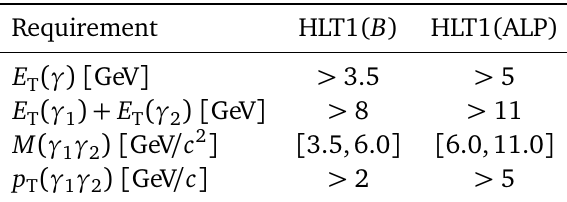
Table 1: Selection applied in the HLT1(B) and HLT1(ALP) triggers. Energies and masses given here are computed with 2 × 2 cell clusters.